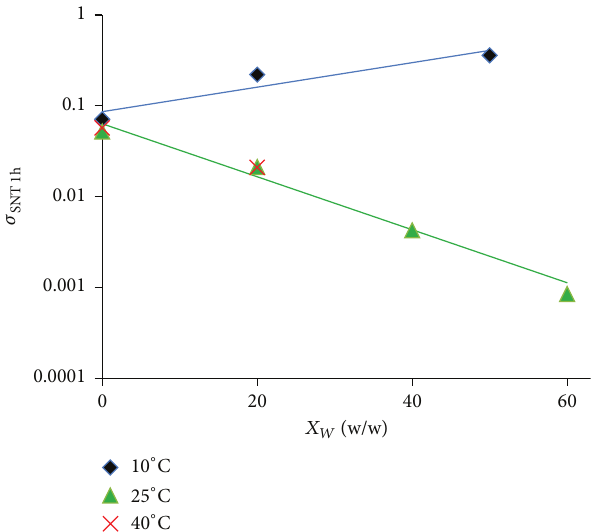
Figure 8: Effect of water concentration on the 1h SNT values.